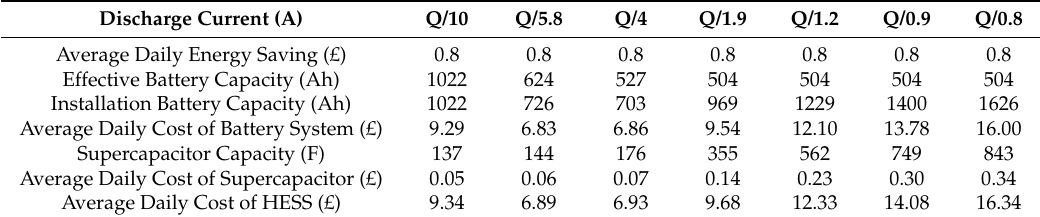
Table 3. Average daily HESS cost for discharge currents (SOC = 70%).